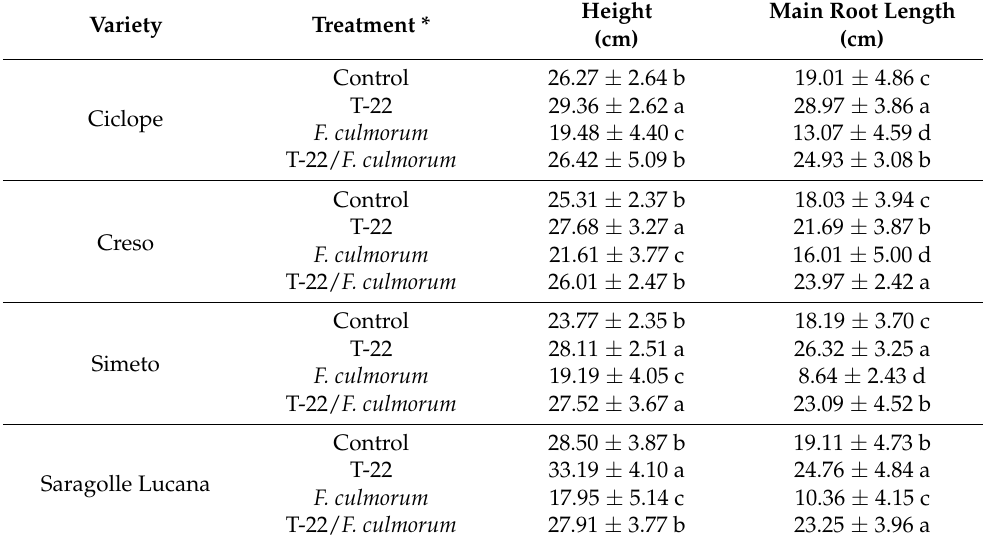
Table 4. Seedling height and main root length in the four Italian tetraploid durum wheat seeds treated with Trichoderma harzianum T-22 and sown in a substrate with F. culmorum , measured at 21 days after